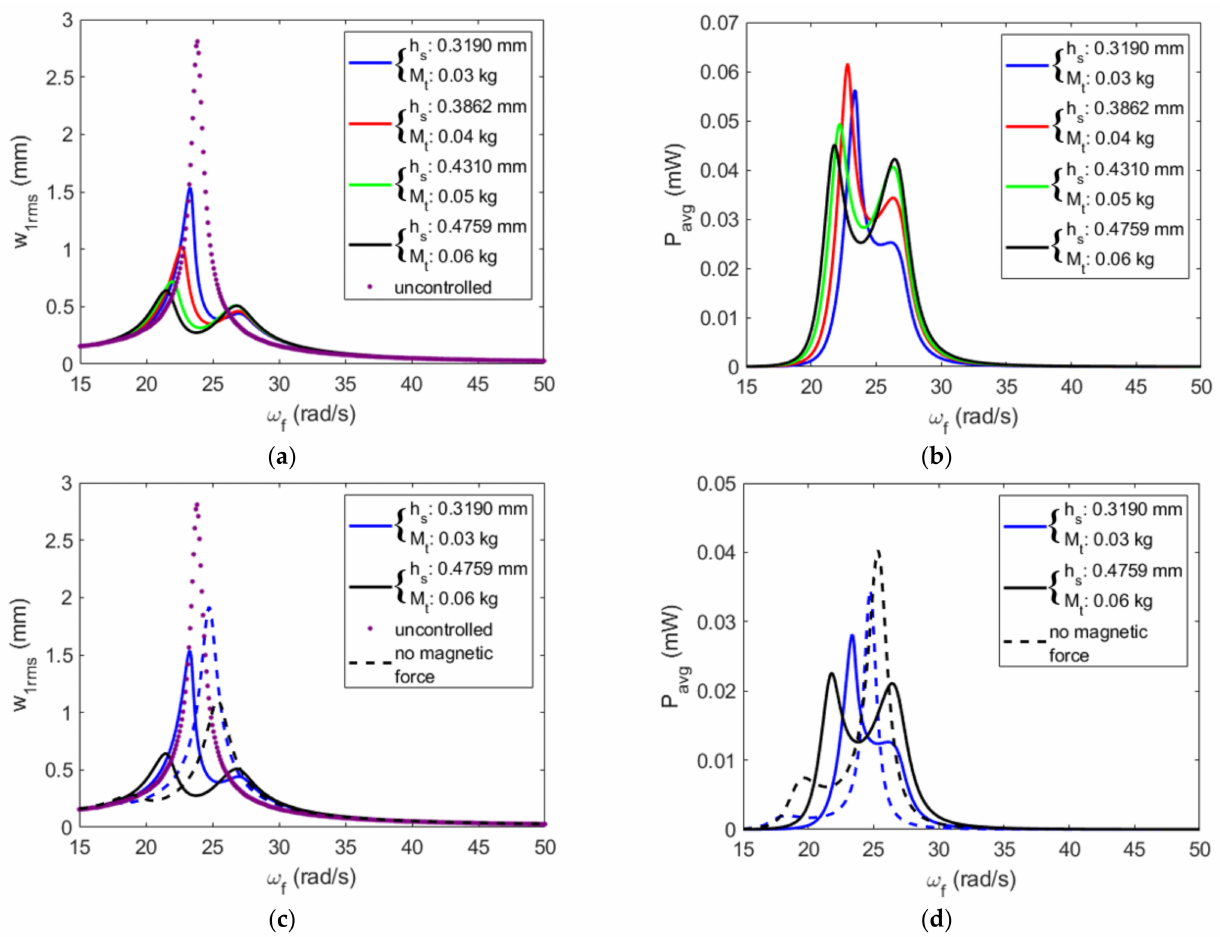
Figure 22. The effects of paired substrate thicknesses and tip masses that induce strong coupling and an initial gap of 10 mm on the amplitude of the ( a ) primary structure and ( b ) absorber, as well as a comparison with configurations with no magnets ( c , d ).